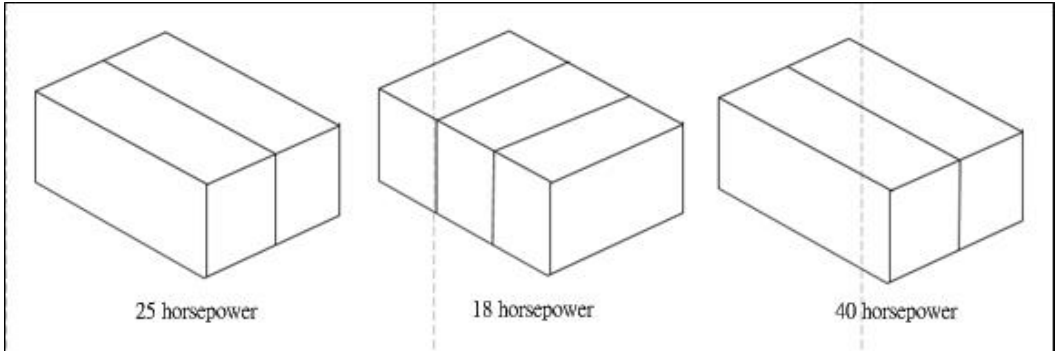
Figure 6. Outboard motor stacking model.